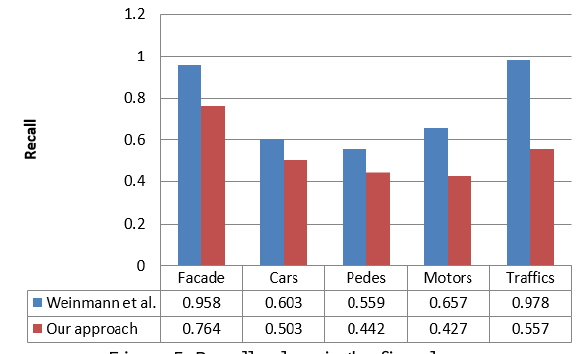
Figure 5. Recall values in the five classes